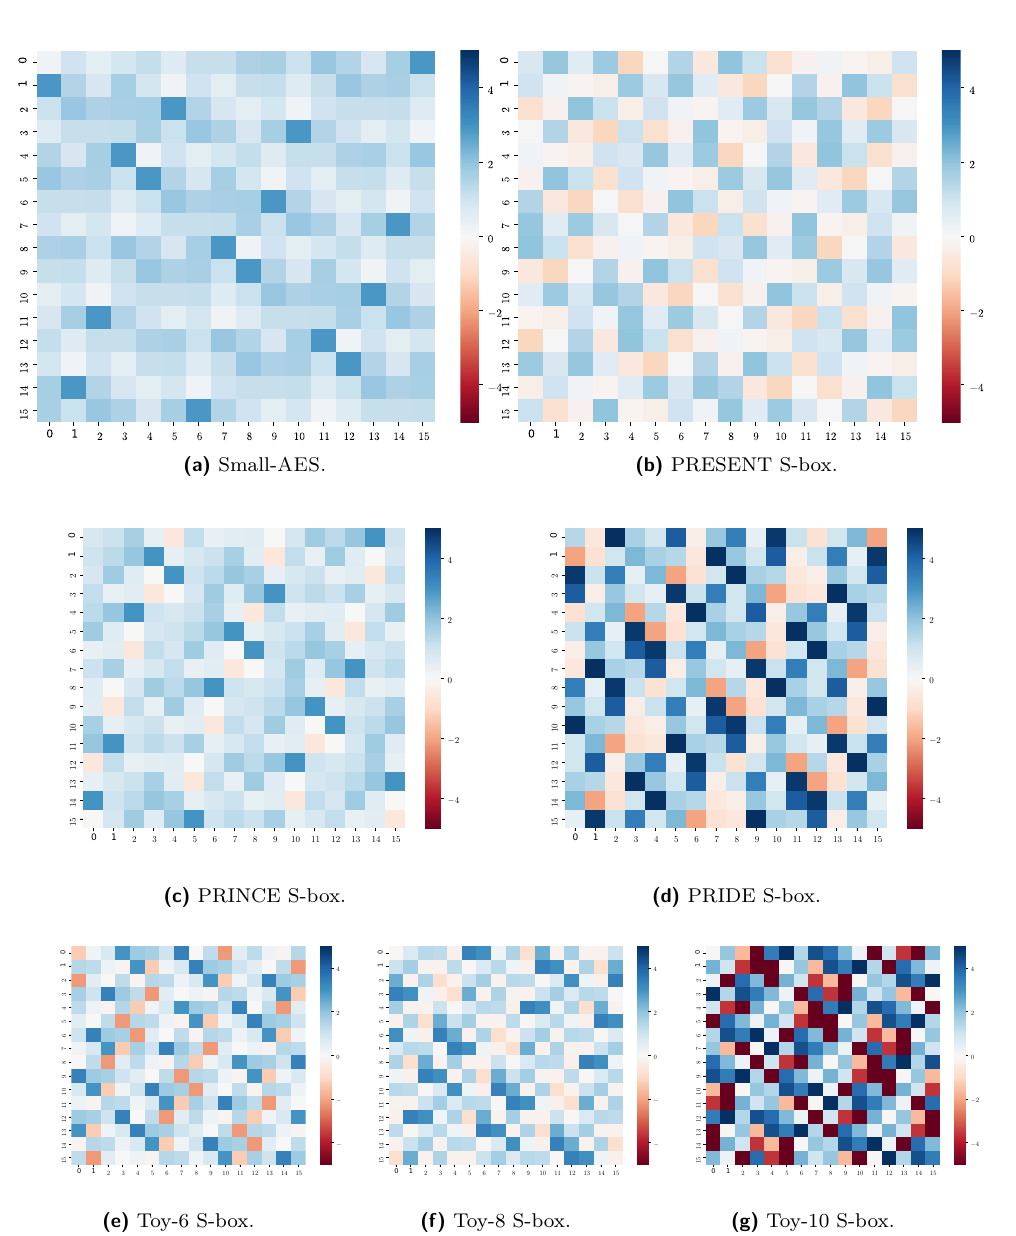
Figure 21: Theoretical index-dependent means from the equation system for our four-round distinguisher with different S-boxes, in ×| p deviations from the mean of the PRP. Small-AES − p rand | Each cell represents the result for the active input cell in the plaintexts ( y -axis) and the tested inactive cell ( x -axis) after four rounds without the final MixColumns operation. Darker colors (ignorant of sign) imply better